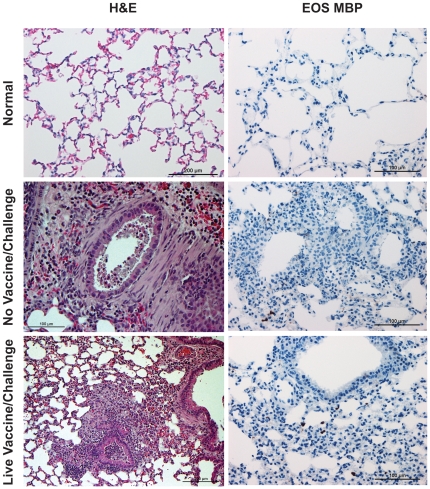
Photomicrographs of Lung Tissue.Representative photomicrographs of lung tissue from unvaccinated unchallenged mice (normal) and from Balb/c mice two days after challenge with SARS-CoV that had previously been given PBS only (no vaccine) or live virus. H&E and immunohistochemical stains for eosinophil major basic protein were performed as described for figure 5. The H&E column is on the left and the Eos MBP column is on the right. Shown are sections from normal mice (no vaccine or live virus) and mice given PBS (no vaccine) or live SARS-CoV and then challenged with SARS-CoV. As shown in the middle and bottom row images, although exposure to SARS-CoV elicits inflammatory infiltrates and accumulation of debris in the bronchial lumen, eosinophils in all groups remain within normal limits.